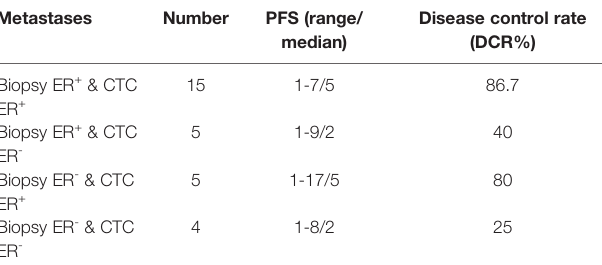
TABLE 3 | Expression pro fi les for ER of IHC results and CTCs, and available PFS and DCR information in the subgroup of patients with available metastatic IHC results.